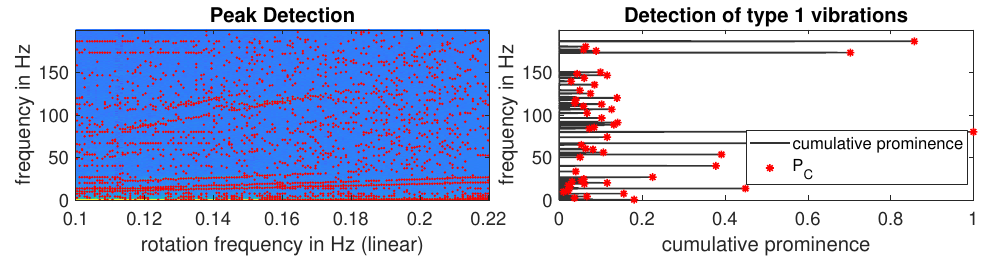
Figure 7. Detection of Type 1 vibrations: ( Left ) Linear-scale spectrogram with identified peaks P all visualised; and ( right ) cumulative prominence C cum ( k ) of identified peaks with highlighted locations P C corresponding to locations of identified Type 1